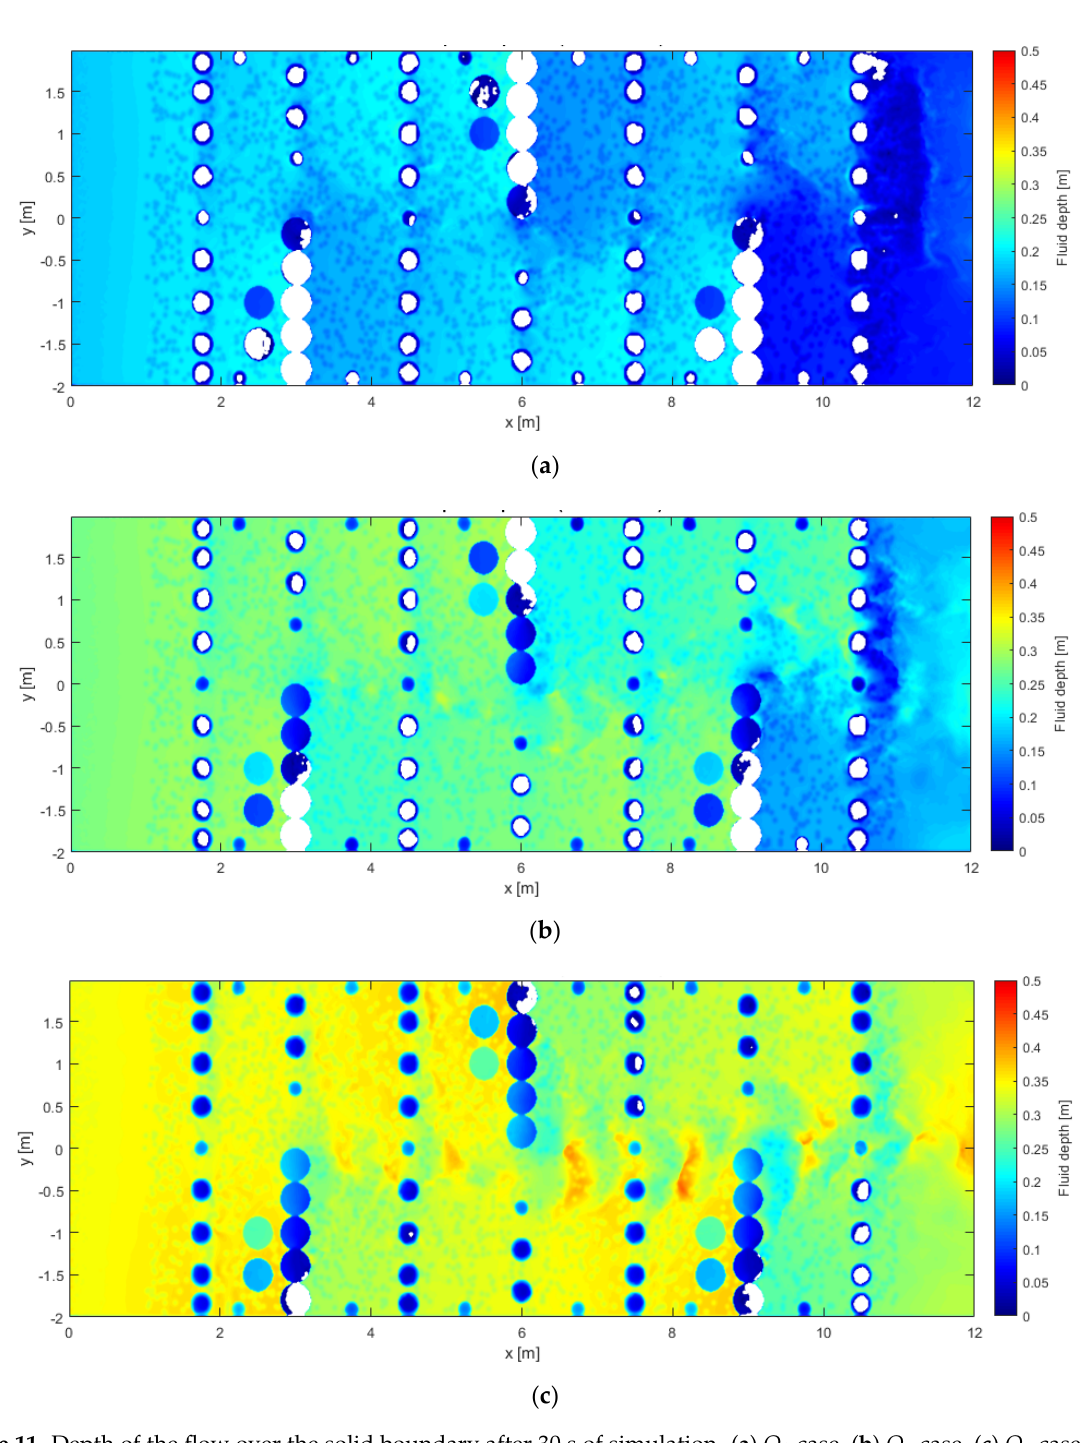
Figure 11. Depth of the flow over the solid boundary after 30 s of simulation. ( a ) Q 1 case, ( b ) Q 2 case, ( c ) Q 3 case. Flow from left to right.